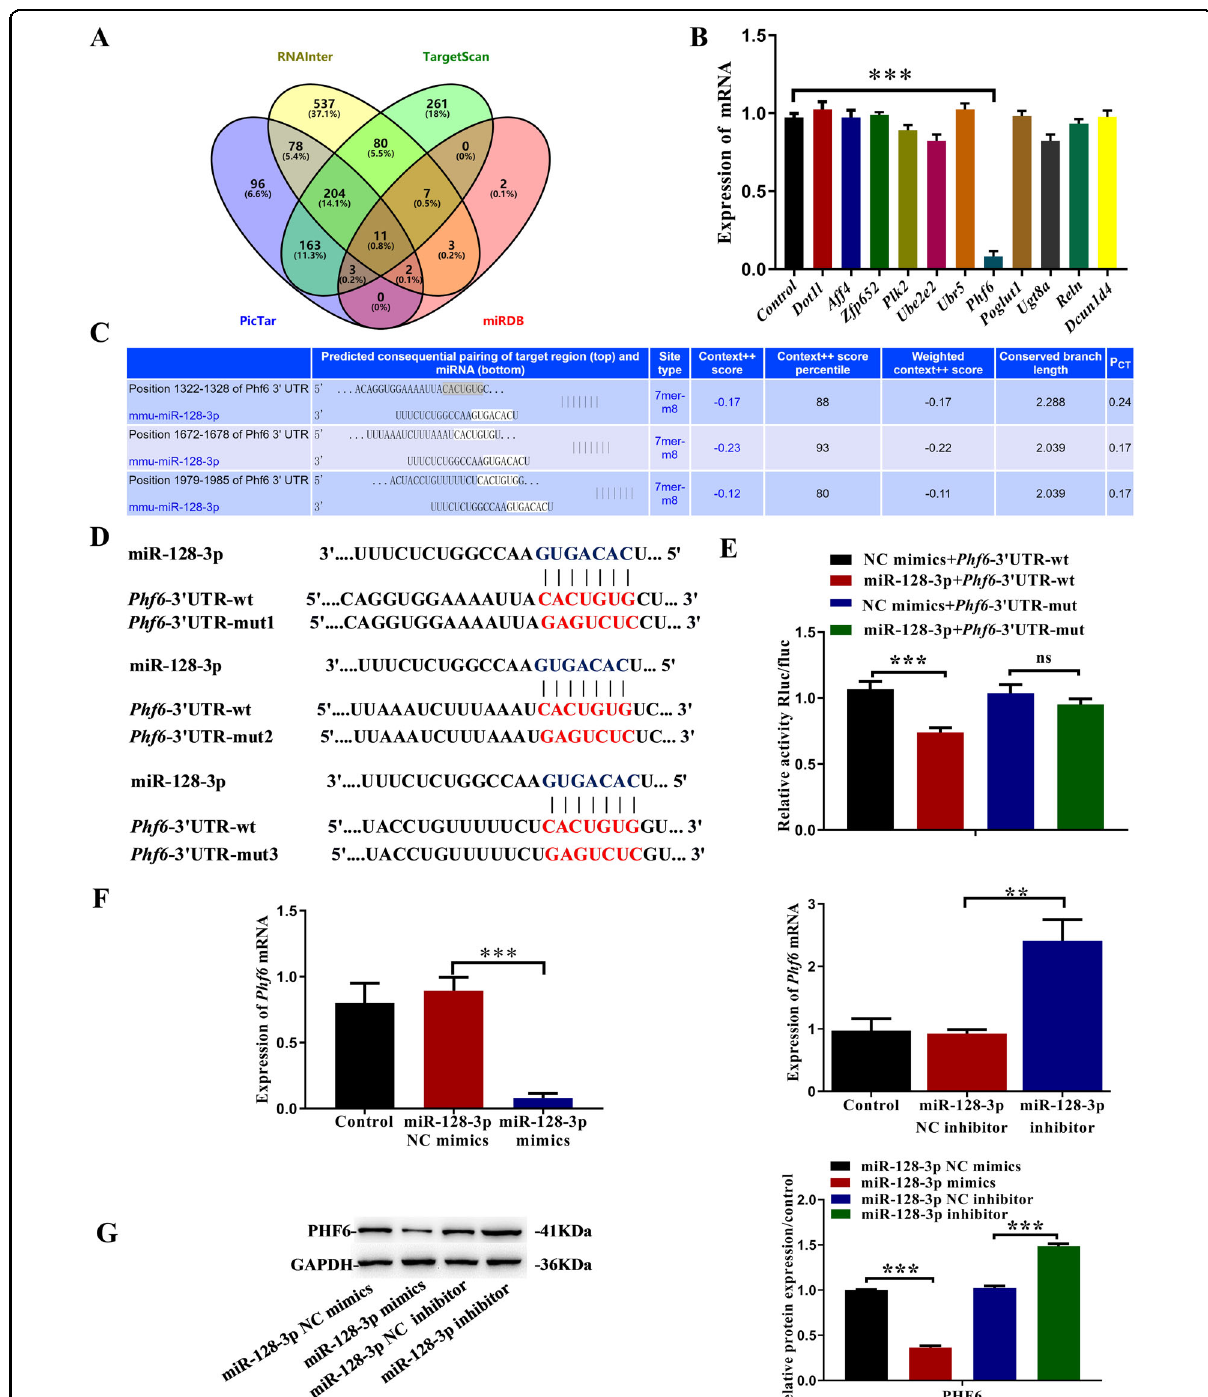
Fig. 6 Phf6 is the target gene of miR-128-3p. A A Venn diagram indicated that 30 genes may be functional targets of miR-128-3p. B qRT-PCR showed that miR-128-3p dramatically reduced the mRNA expression level of Phf6 . C The predicted sequence between miR-128-3p and Phf6 using TargetScanMouse. D The mutant binding sites of miR-128-3p at the 3 ′ UTR of Phf6 mRNA. E Relative luciferase activities of Phf6 − 3 ′ UTR-wt or Phf6 − 3 ′ UTR-mut were analyzed in HEK293T cells after co-transfection with miR-128-3p mimic or mimic NC. The luciferase activity was normalized to the ratio of fi re fl y to the renilla activity ( n = 3). F , G qRT-PCR and western blot analysis were used to detect the PHF6 expression in IEC-6 cells transfected with miR-128-3p mimic and miR-128-3p inhibitor ( n = 3). All data were demonstrated as mean ± SD from three independent experiments performed in duplicate. * p < 0.05, ** p < 0.01, *** p < 0.001, and **** p < 0.0001 were all signi fi cant